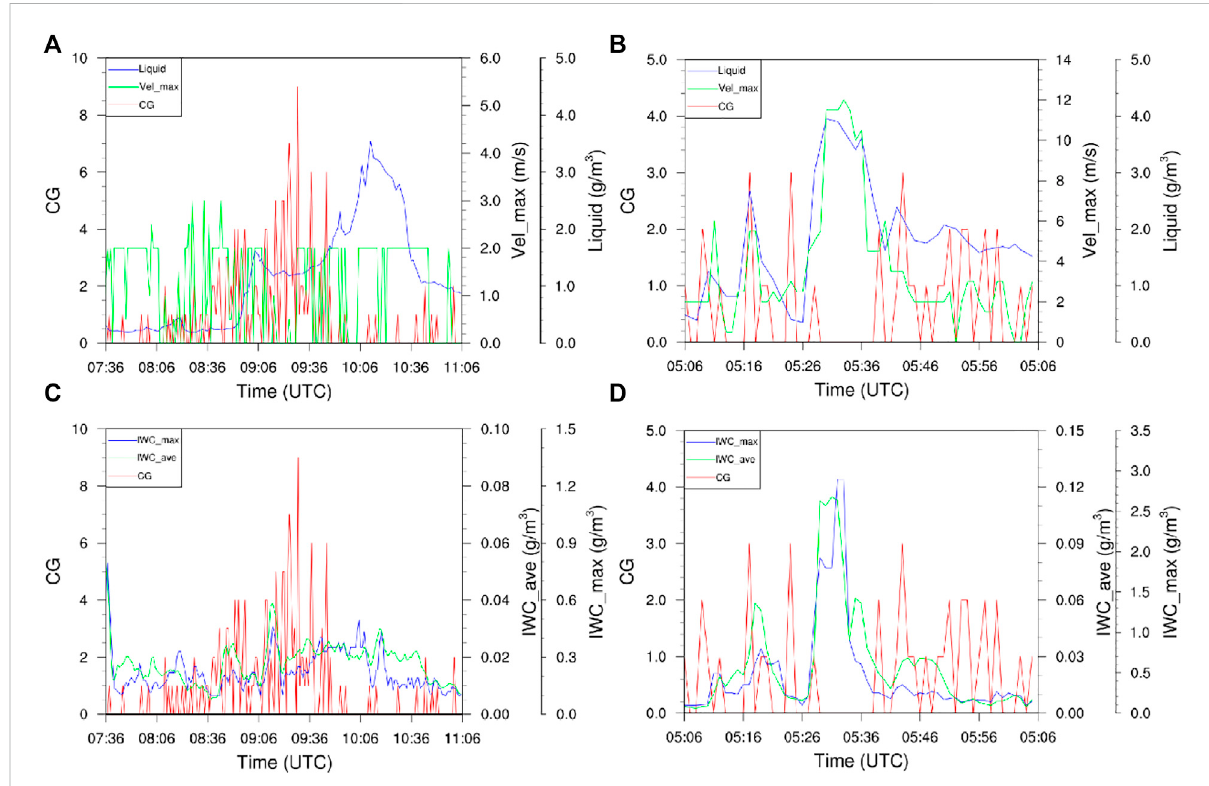
FIGURE 11 The time series of CG lightning (red), the maximum radial velocity (green), and the total liquid water content (blue) for (A) PV thunderstorm and (B) TC thunderstorm. The time series of CG lightning (red), the average ice water content (green), and the maximum ice water content (blue) for (C) PV thunderstorm and (D) TC